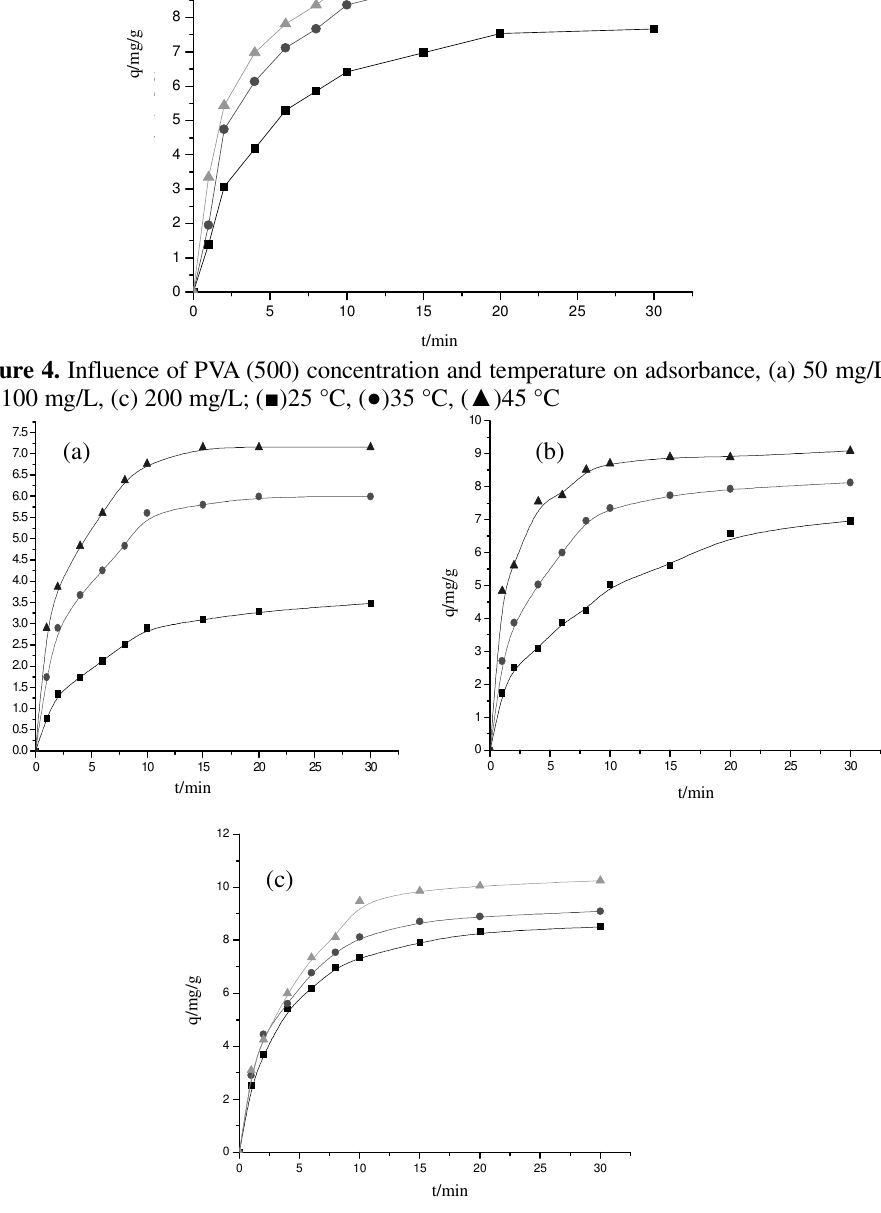
Figure 5. Influence of PVA (700) concentration and temperature on adsorbance, (a) 50 mg/L, (b) 100 mg/L, (c) 200 mg/L; ( ■ )25 °C, ( ● )35 °C, ( ▲ )45